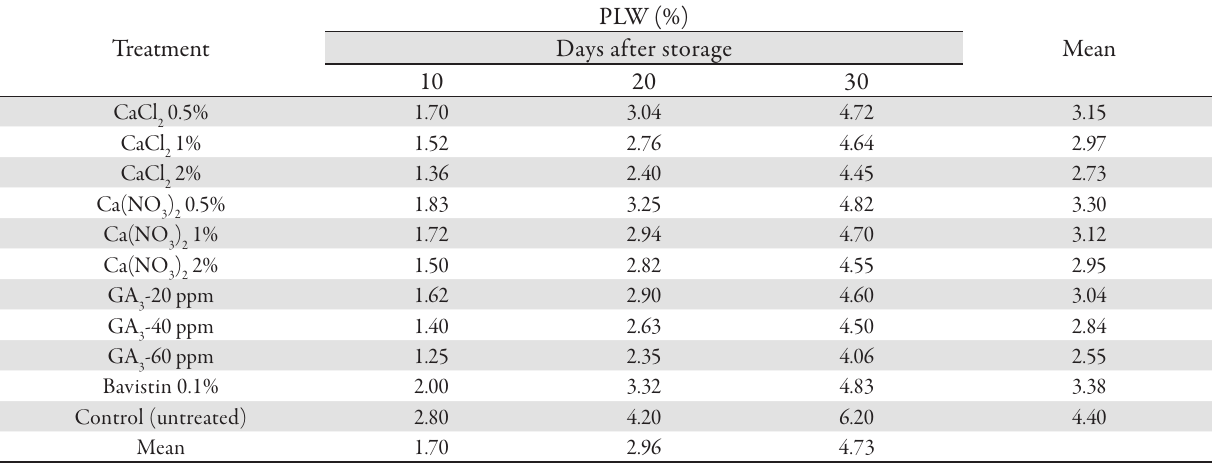
Tab. 2. Effect of different post-harvest treatments on fruit firmness of ber fruits during cold storage Treatment